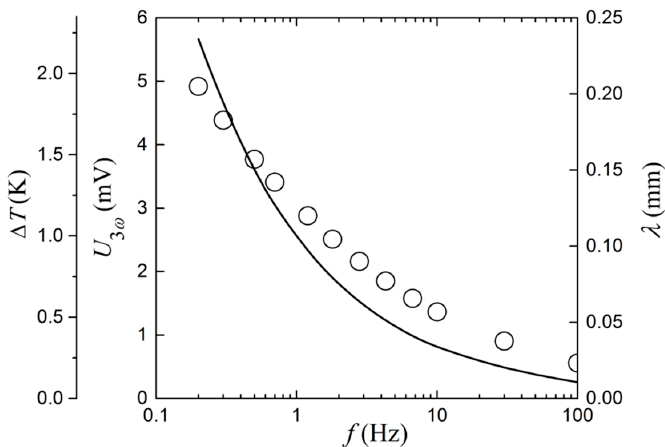
Figure 5 . Amplitude of the 3 ω signal, and temperature oscillations (left y-axes, circles) and thermal wavelength (right y-axis, continuous line) as functions of the frequency.